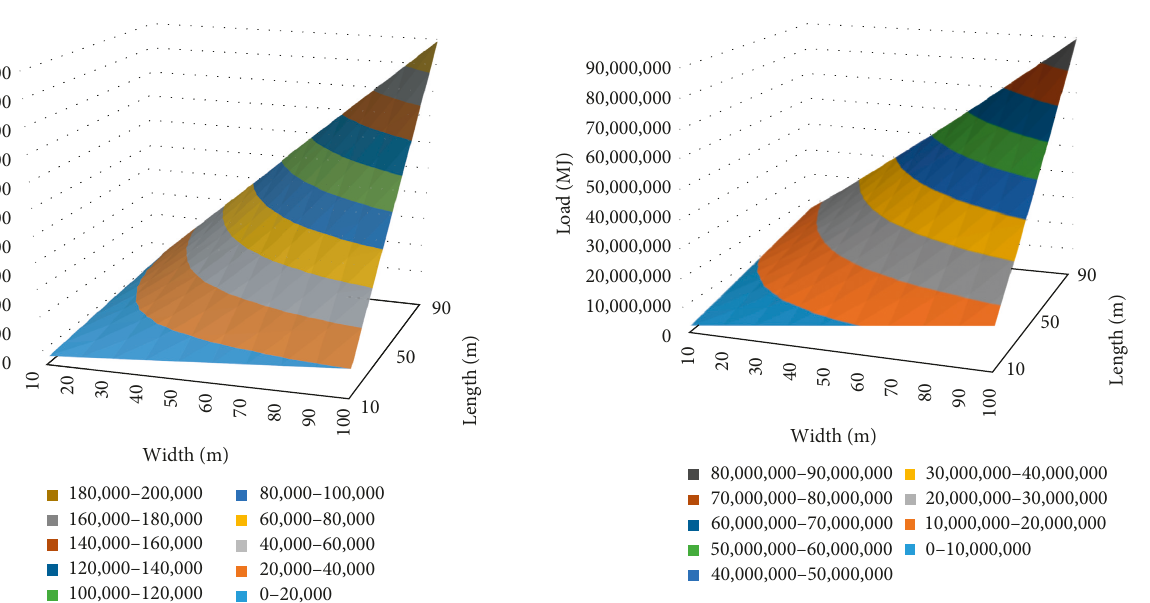
Figure 11: Changes in physical properties according to mass scale: floor area (m 2 ).